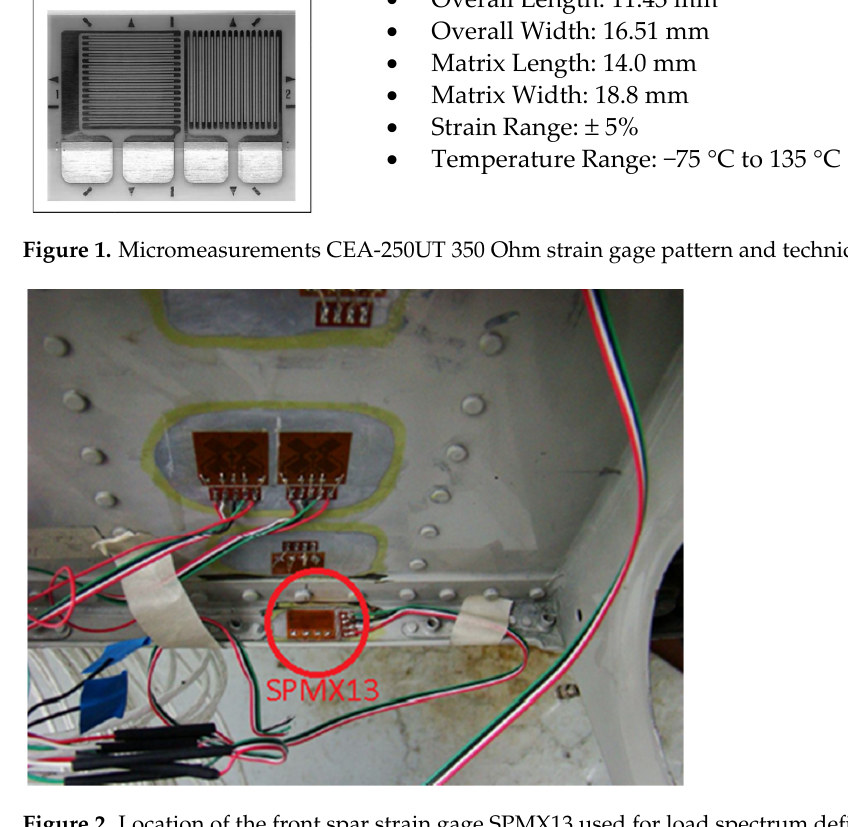
Figure 2. Location of the front spar strain gage SPMX13 used for load spectrum definition.